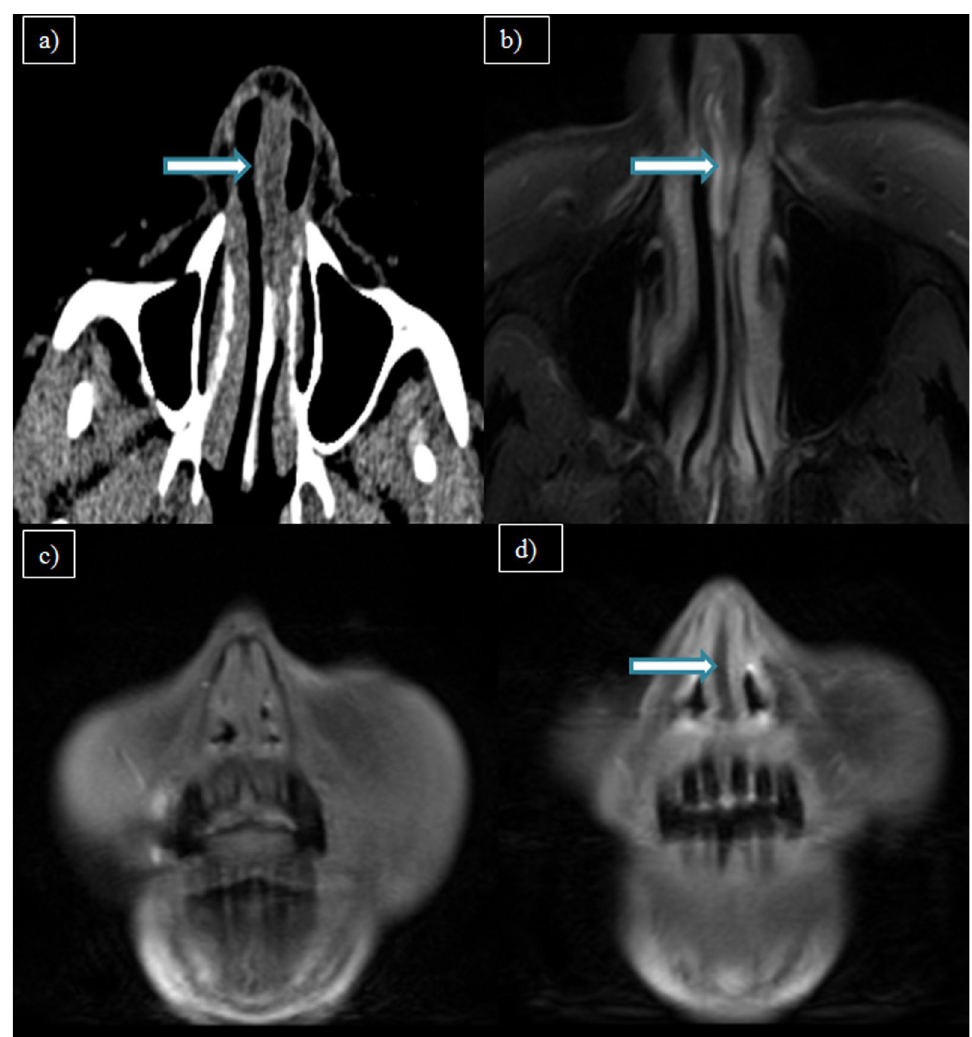
septum with hypodense collection (arrow). b MRI axial T2W-FS, c coronal pre-contrast T1W-FS and d coronal post-contrast T1W-FS images of same patient showing peripherally enhancing collection in the cartilaginous part of nasal septum(arrow)–nasal septal